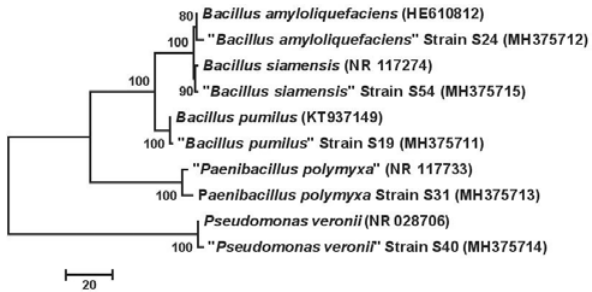
Figure 3. Neighbour-joining tree based on 16S rDNA sequences showing the phylogenetic relationship between strains S19, S24, S31, S40 and S54. Bootstrap values (expressed as percentages of 1000 replications) >70% are given at the